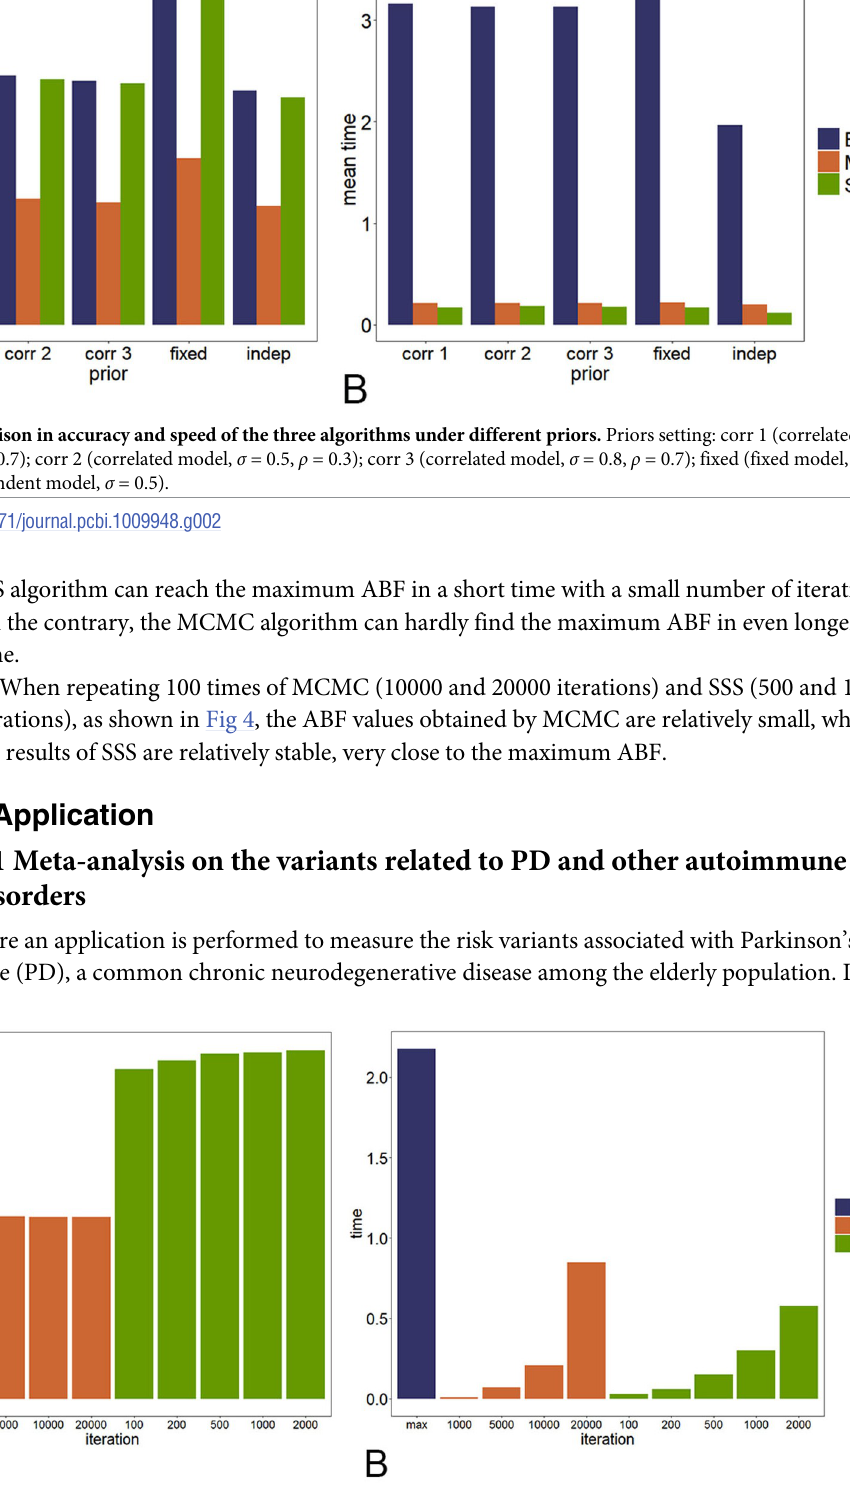
Fig 3. The comparison in accuracy and speed of the three algorithms under different iterations.